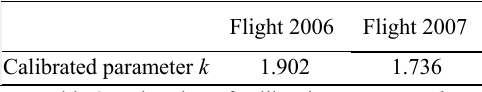
Table 3 Estimation of calibration parameter k